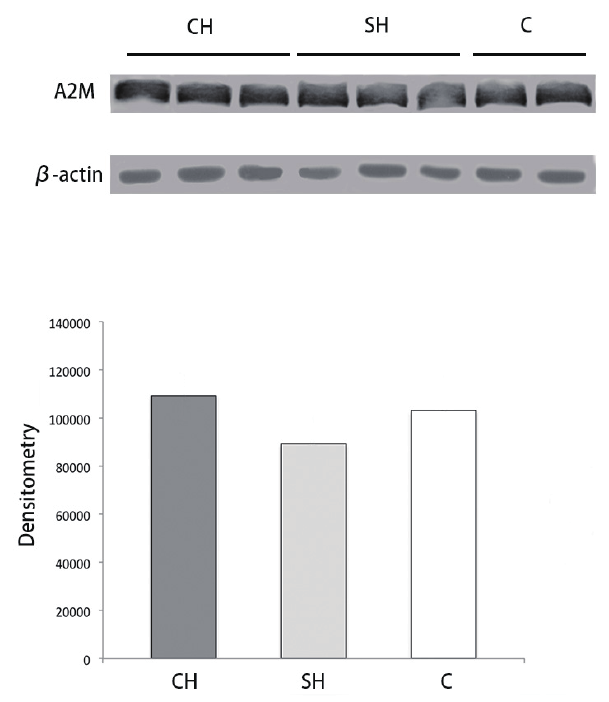
Figure 5. Alpha-2-macroglobulin (A2M) was compared among the three groups for validation by western blot (WB) analysis. Upper figure: Three clinical hypocalcemia (CH) group samples and three subclinical hypocalcemia (SH) group samples were subjected to western blotting analysis of A2M including two normal plasma controls. Lower figure: A2M protein expression in all